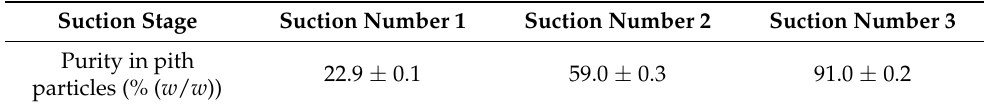
Table 2. Purity in pith particles of the sucked fraction after each suction stage.